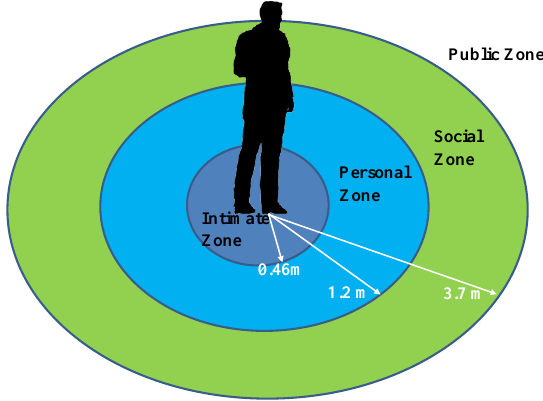
Figure 3. Hall’s proxemic zones introduced in